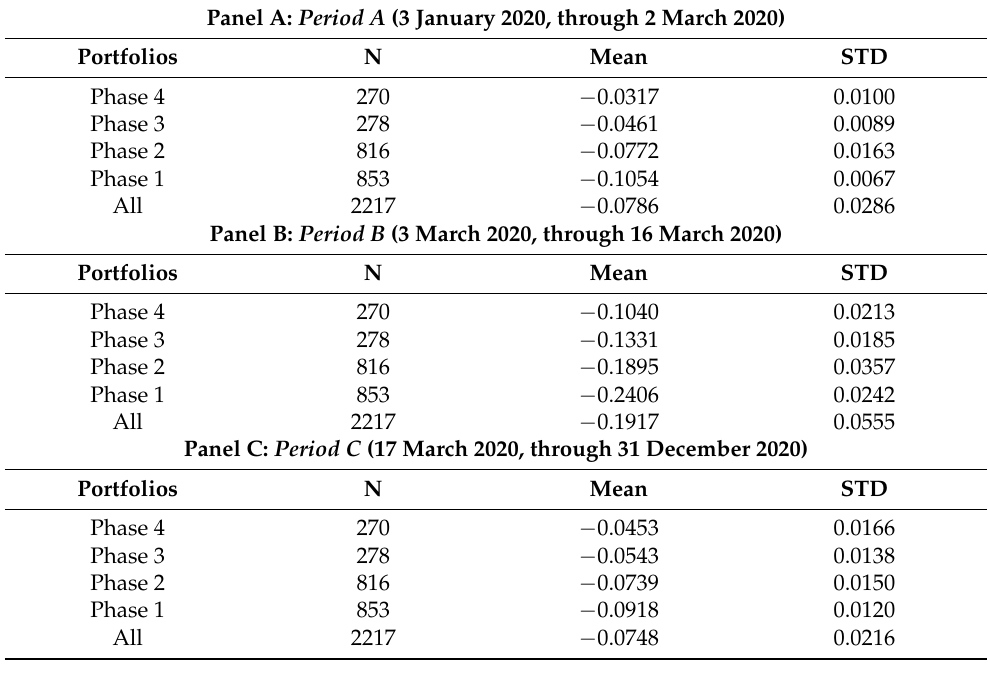
Table 4. Maximum Drawdown Statistics by Portfolio Classification (Three Sub-Sample